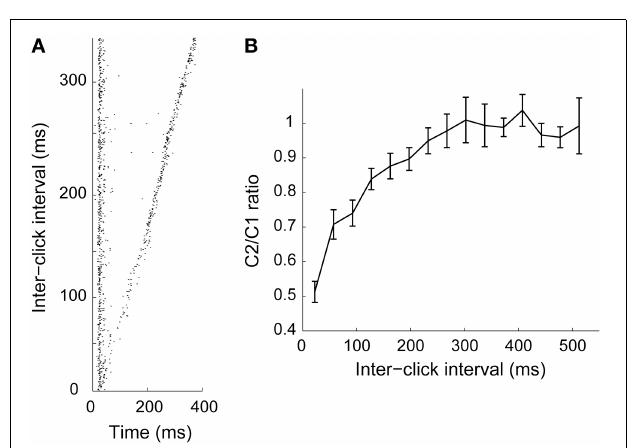
speaker location. The receptive field showed excitation at the center flanked by suppression. (C) Surround activation sharpens the spatial tuning. For most cells ( n = 81), the width of spatial-tuning curves was narrower when both center and surround were stimulated (points above the unity line) compared to when only the center was stimulated. Modified from Wang et al. (2012).